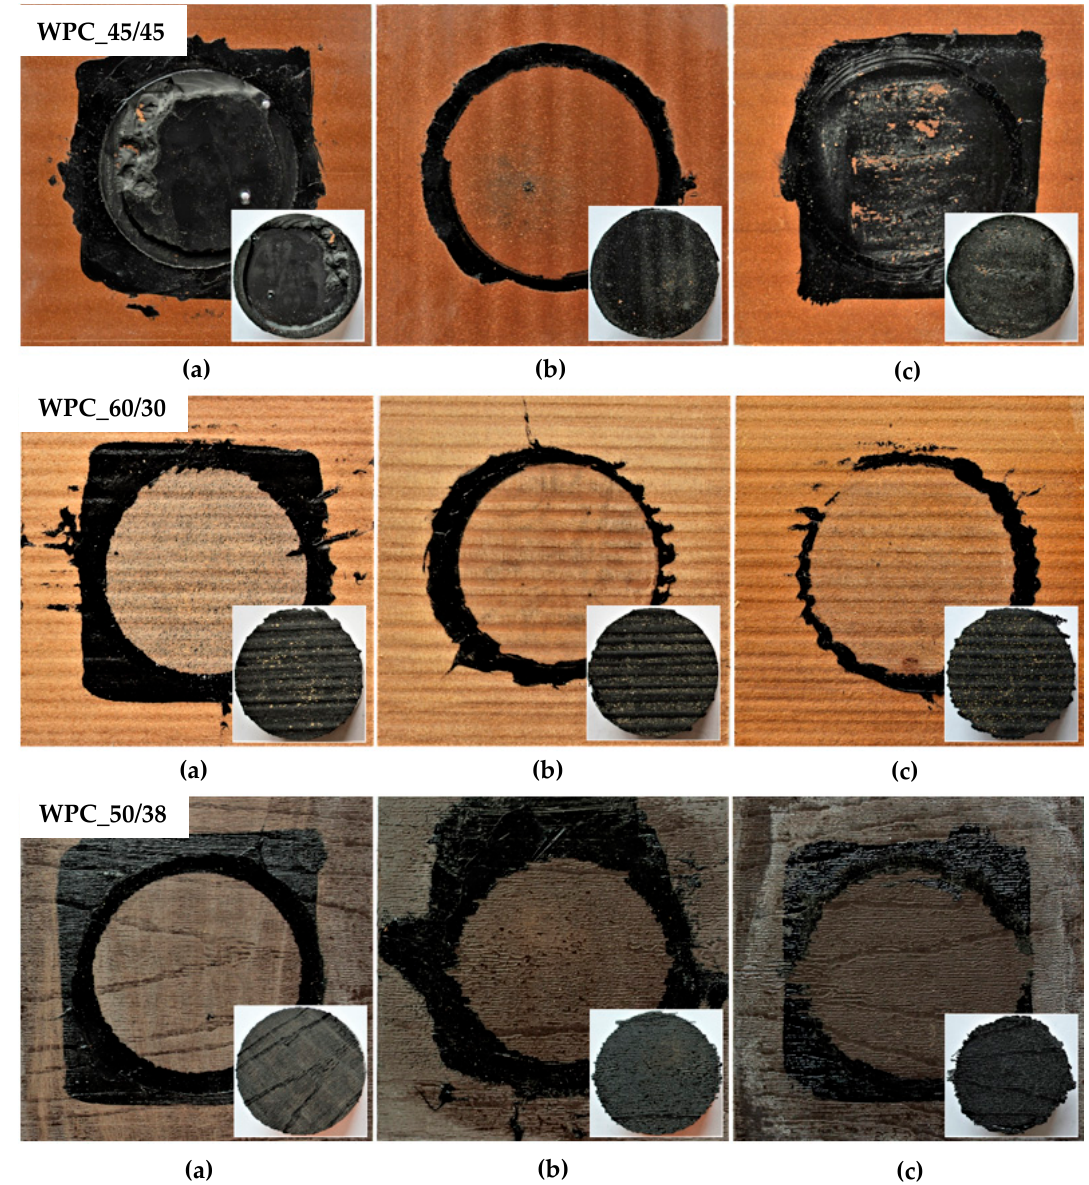
Figure 5. Typical failure mode of test samples after adhesion (tensile) test: WPC_45/45 ( a ) sample with primer, plasma treatment (86% AF; 14% CF); ( b ) sample without primer, chemical treatment (100% AF); ( c ) sample with primer, chemical treatment (100% AF); WPC_60/30 ( a ) sample with primer, chemical treatment (100% AF); ( b ) sample without primer, mechanical treatment (100% AF); ( c ) sample without primer, chemical treatment (100% AF); WPC_50/38 ( a ) sample with primer, mechanical treatment (100% AF); ( b ) sample without primer, plasma treatment (100% AF); ( c ) sample with primer chemical treatment (100% AF).